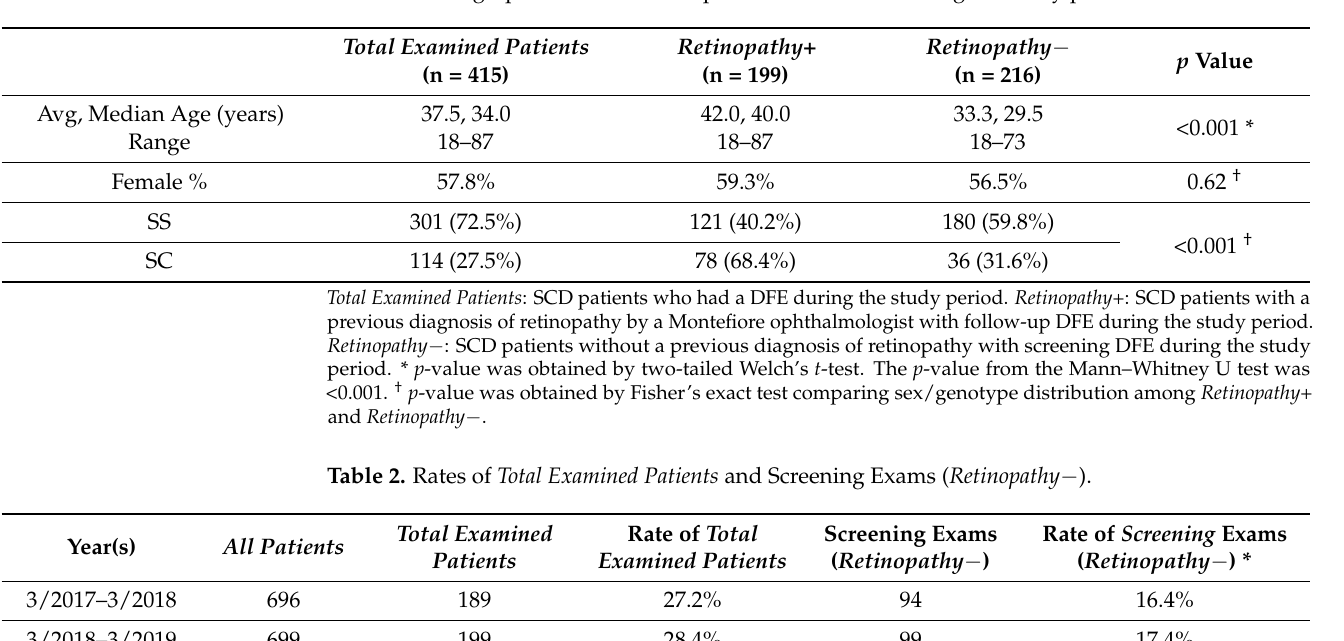
All Patients : Total SCD patients seen by a physician during the timeframe. Total Examined Patients : SCD patients who had an eye exam during the timeframe. Rate of Total Examined Patients : Rate of SCD patients with an eye exam, Total Examined Patients / All Patients. Screening exams: Number of SCD patients without a previous diagnosis of retinopathy ( Retinopathy − ) who had a (screening) eye exam during the timeframe. Rate of screening exams: a rate of screened patients among SCD patients without a previous diagnosis of retinopathy ( Retinopathy − ). * Rate of screening exams was calculated as follows: ( Retinopathy − with screening exams)/( All Patients − (retinopathic patients)) = ( Retinopathy − with screening exams)/( All Patients − (SCD patients not seen by a Montefiore ophthalmologist but with retinopathy noted in EMR + ( Retinopathy+